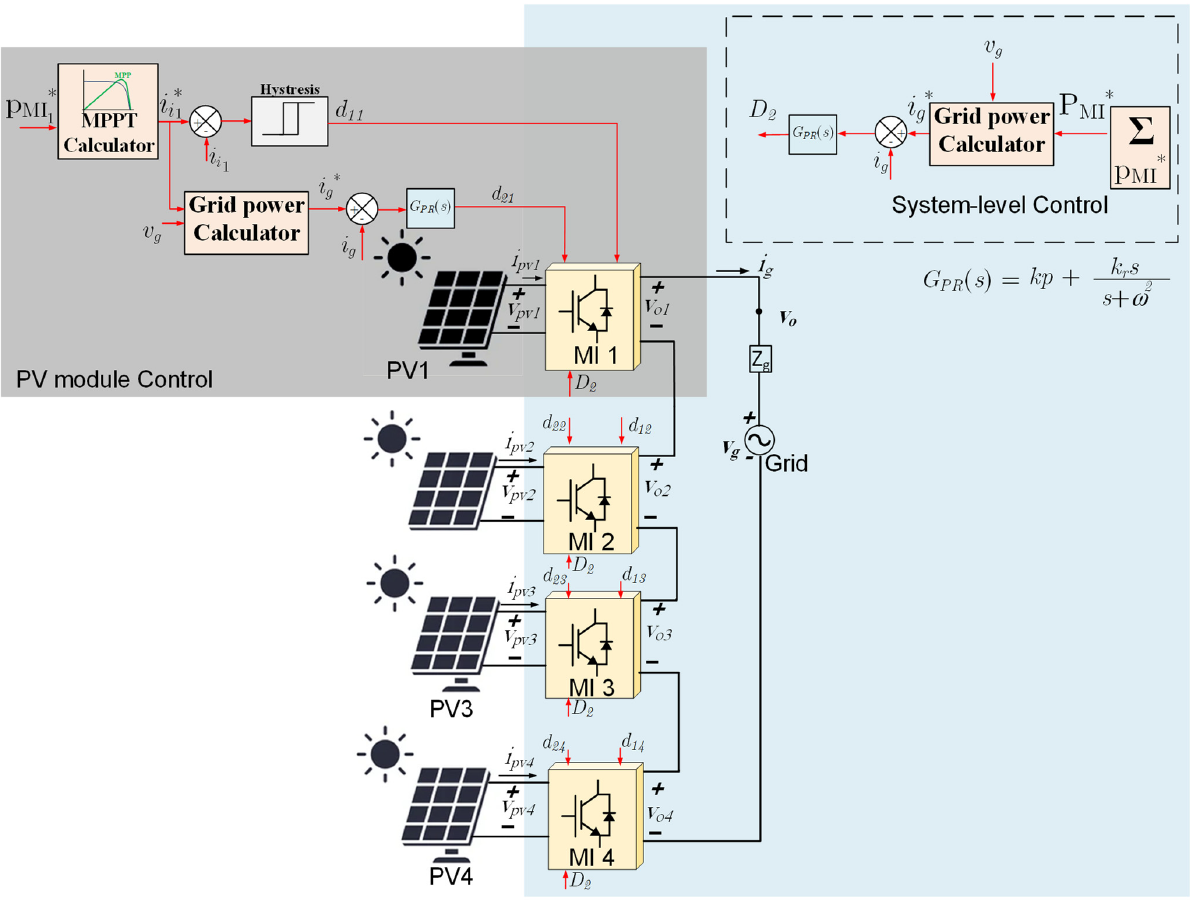
Figure 16. MCI, PV module, and system-level controllers for PV/grid DC/AC inversion.